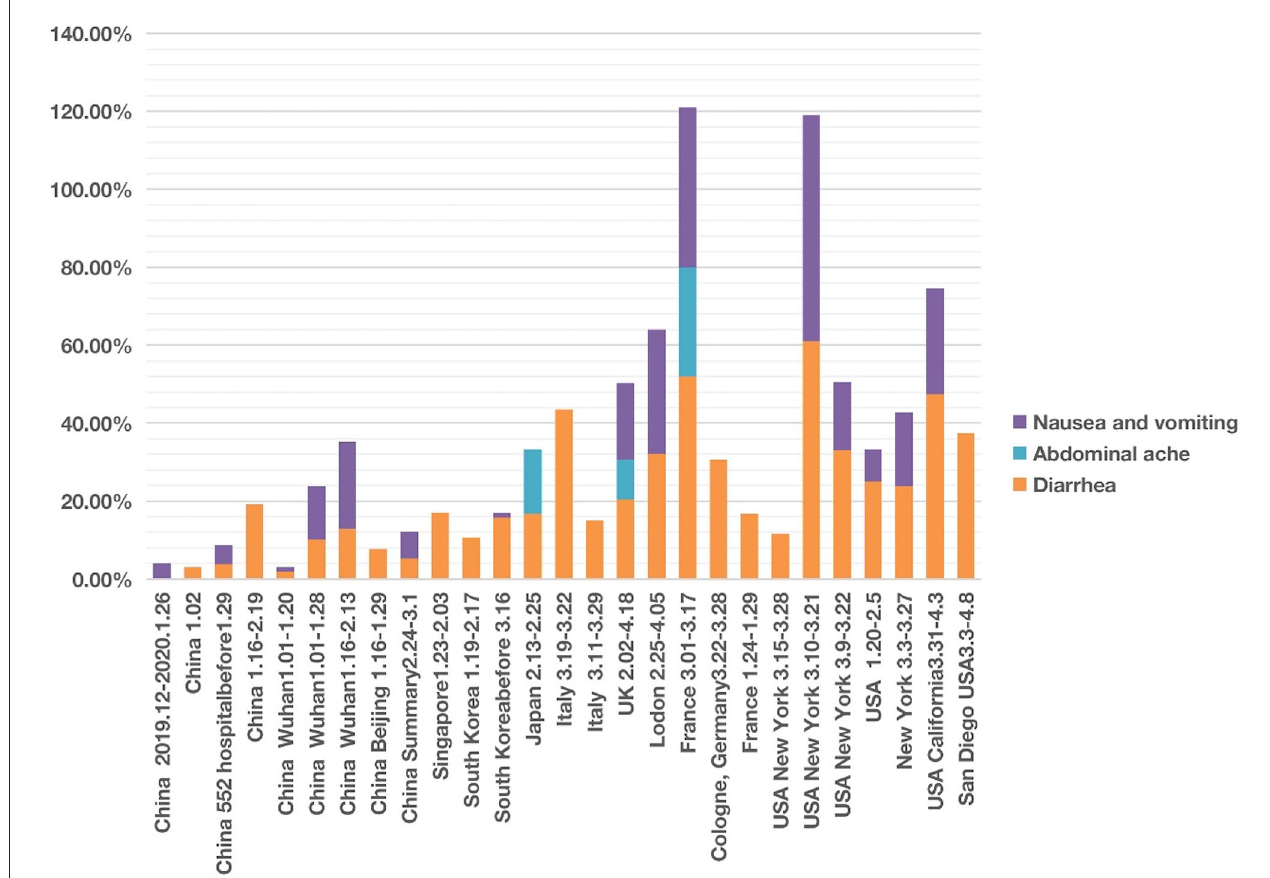
FIGURE 4 | COVID-19 cases with four abdominal system symptoms in different countries from December 2019 to May 2020. Four symptoms (i.e., nausea, vomiting, abdominal pain, and diarrhea) were analyzed. Each symptom has 0–100% of